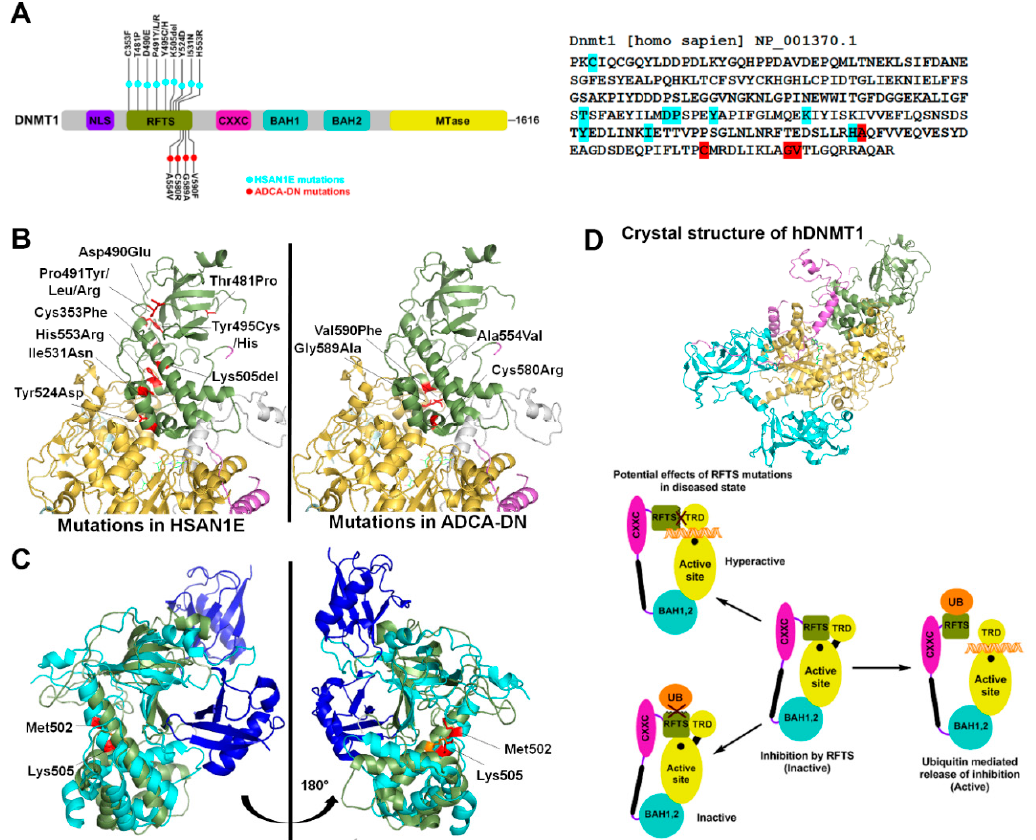
Figure 1. HSAN1E (hereditary sensory neuropathy with dementia and hearing loss) and ADCA-DN (autosomal dominant cerebellar ataxia, deafness and narcolepsy) mutations in DNMT1 ( A ) Left Schematic representation of the hDNMT1 gene. HSAN1E mutations are listed above the gene in light blue, while ADCA-DN mutations are listed below the gene in red. Right Nucleotide sequence of the RFTS (replication foci-targeting sequence) domain, with the mutations highlighted in color corresponding to the schematic. ( B ) Crystal structure of hDNMT1 (351–1600) from the Protein Data Bank (PDB: 4WXX). The cartoon structure of the RFTS domain is green, the CXXC domain is purple, and the MTase (methyltransferase) domain is yellow. All disease mutations are located in the RFTS domain, and are shown as stick structures in red. The positions of HSAN1E and ADCA-DN mutations are shown in the left and right DNMT1 structure respectively. ( C ) Overlay of the hDNMT1 RFTS domain bound (light blue) and unbound (green) to two molecules of ubiquitin (dark blue) from the PDB: 4WXX and 5YDR. When ubiquitin is bound, the RFTS domain bends about 30° at Met502. The HSAN1E mutation Lys505del and Met502 are shown in red in RFTS domain bound to ubiquitin and in orange in the unbound RFTS domain. ( D ) Model showing the effect of mutations in the RFTS domain on the catalytic mechanism of DNMT1. DNMT1 is auto-inhibited by the interaction of its RFTS domain with the target recognition domain (TRD) in MTase domain that prevents DNA binding. When RFTS interacts with ubiquitin, auto-inhibition is released allowing TRD to interact with the hemi-methylated DNA. However, mutations in the RFTS that alter its binding to ubiquitin will prevent enzyme activation, while mutations that alter its binding to the TRD will leave the enzyme in a hyperactive state.